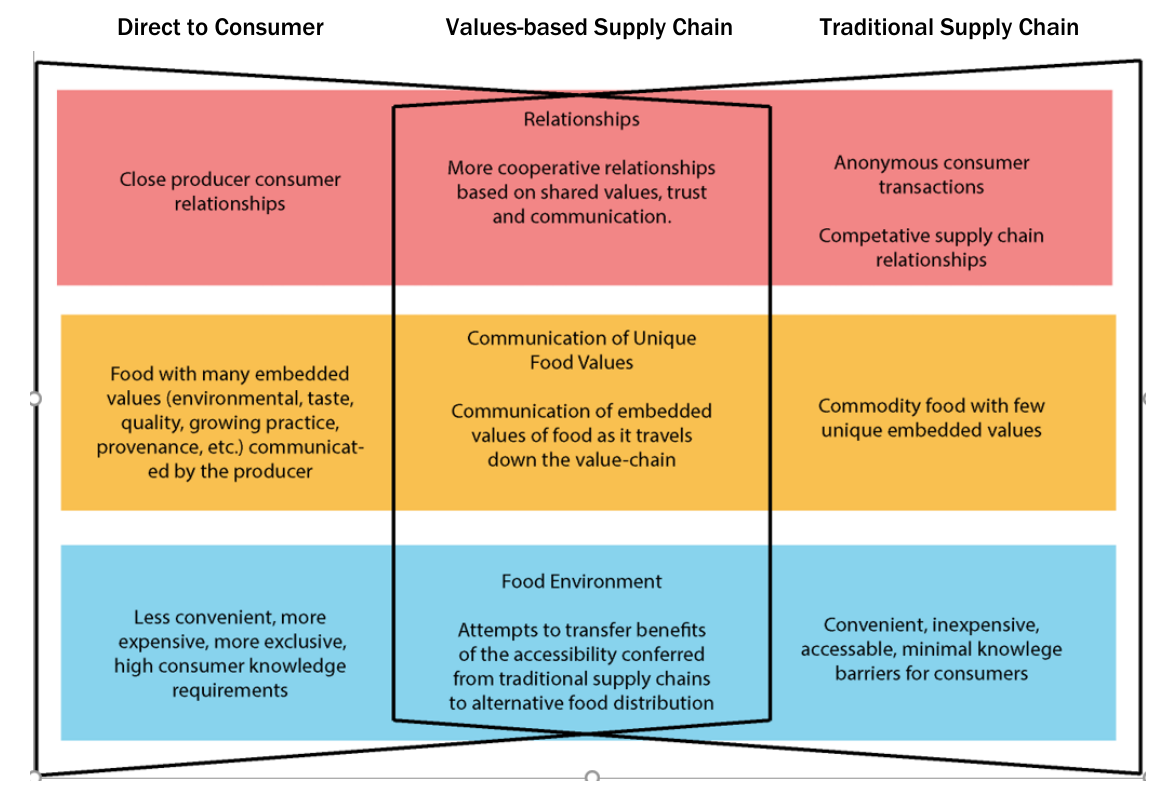
Direct to Consumer Values-based Supply Chain Traditional Supply